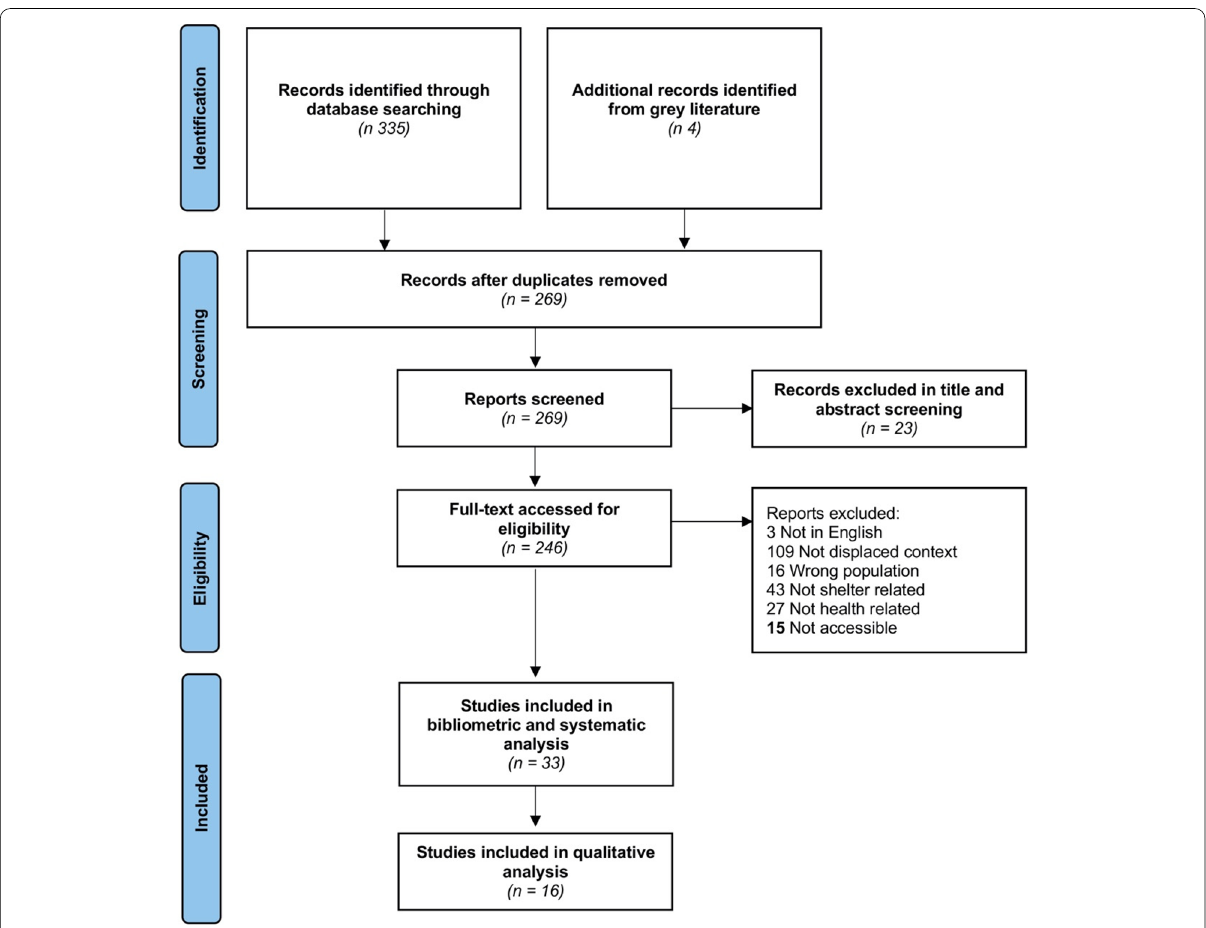
Fig. 1 Flow diagram for a systematic review on shelter and